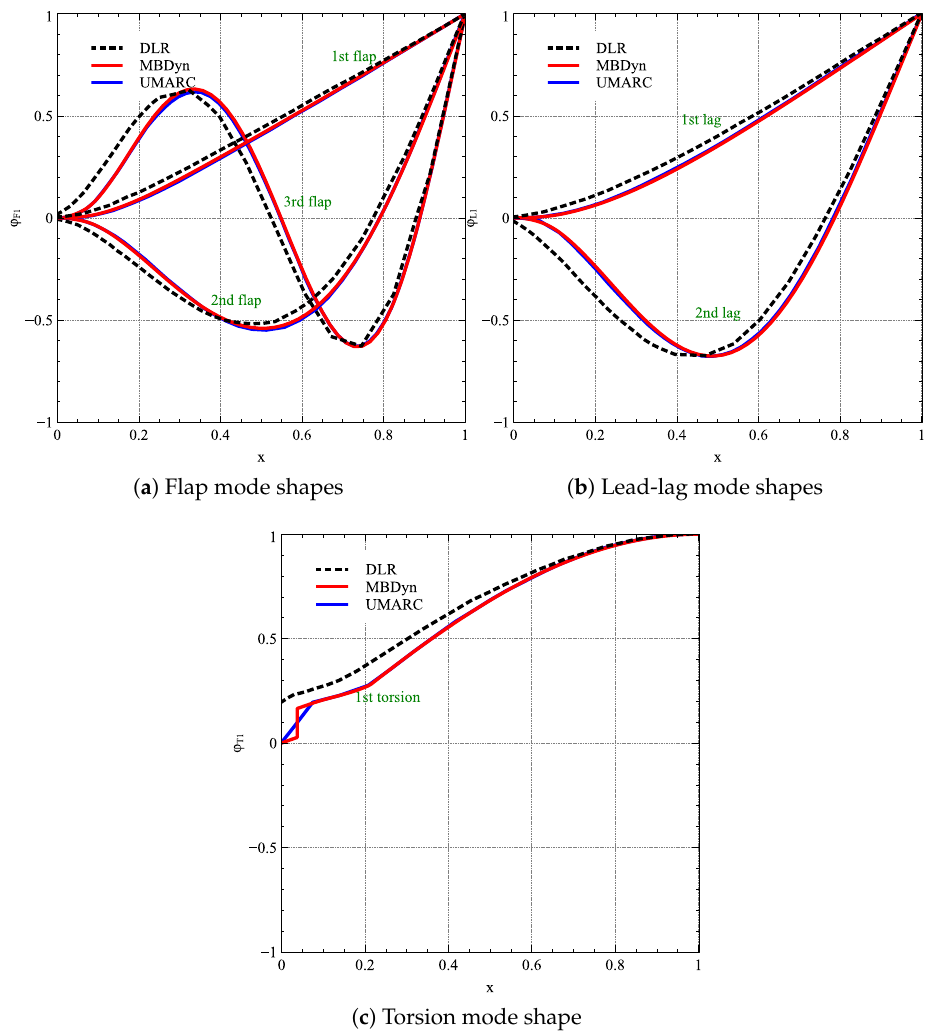
Figure 16. HART II rotor blade natural mode